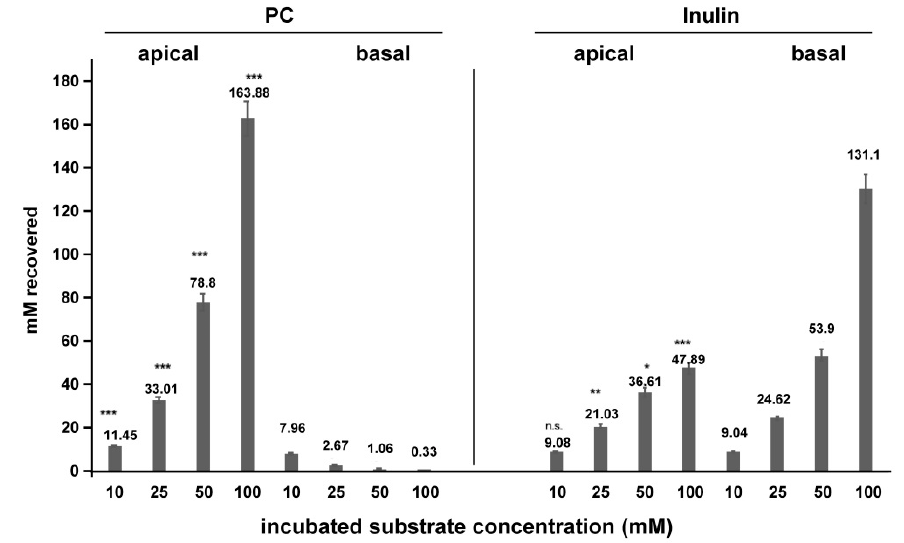
Figure 9. Enhancement of apical phosphatidylcholine (PC) transport by application of increasing concentrations of secretory mucin 1, mucin 2, and taurocholate (TC) as luminal acceptor substances. Apical transport of 10 mM PC: 10 mM TC with polarized Mz-ChA-1 cells was determined as a function of increasing concentrations of mucin 1, mucin 2 and TC in the upper culture system. Means ± SD of n = 6. Significances were calculated in relation to the lowest concentration of each substance added. * p < 0.05; ** p < 0.01; *** p < 0.001.